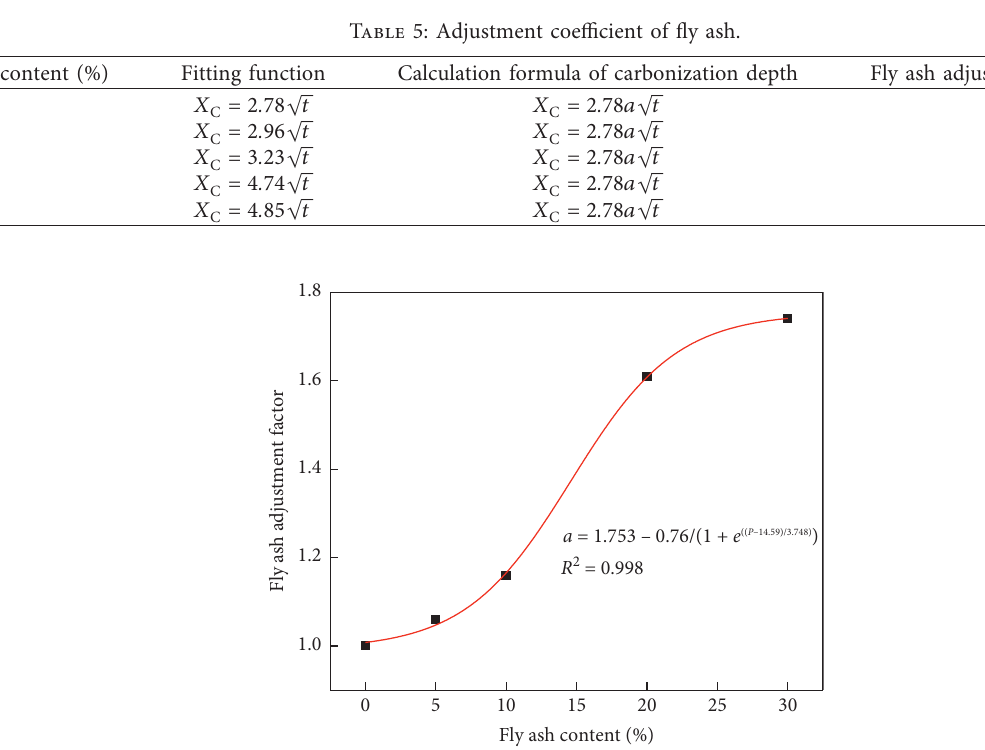
Figure 9: Fitting curve of the fly ash adjustment coefficient.